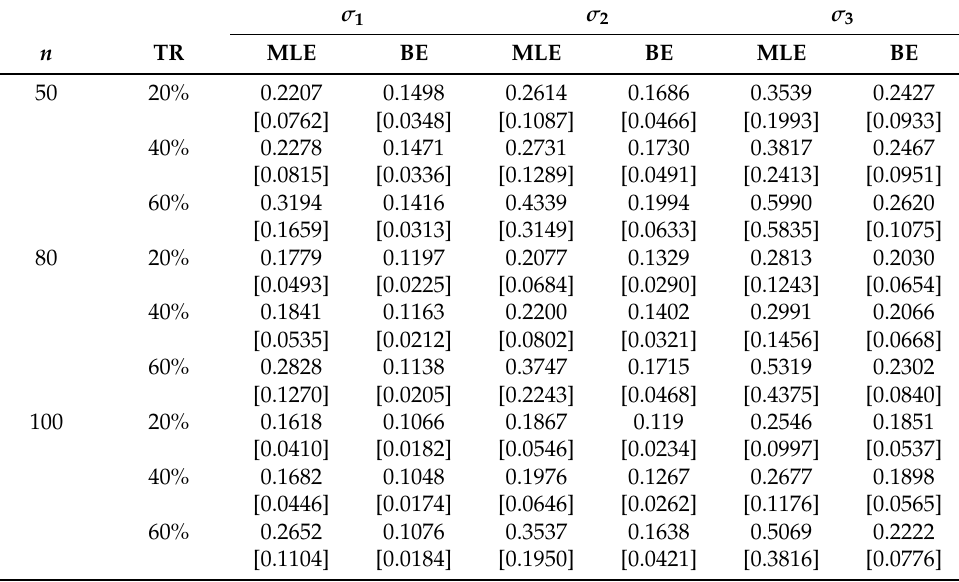
Table 4. ABs and MSEs (within bracket) for parameters with order restriction when ( σ 1 , σ 2 , σ 3 ) = ( 1,1.3,2 )